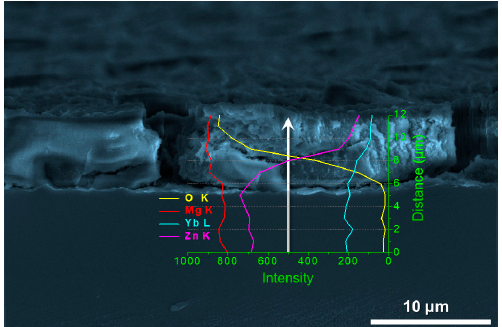
Figure 5. SEM image of cross section of the sample and the corresponding EDS line scanning result.